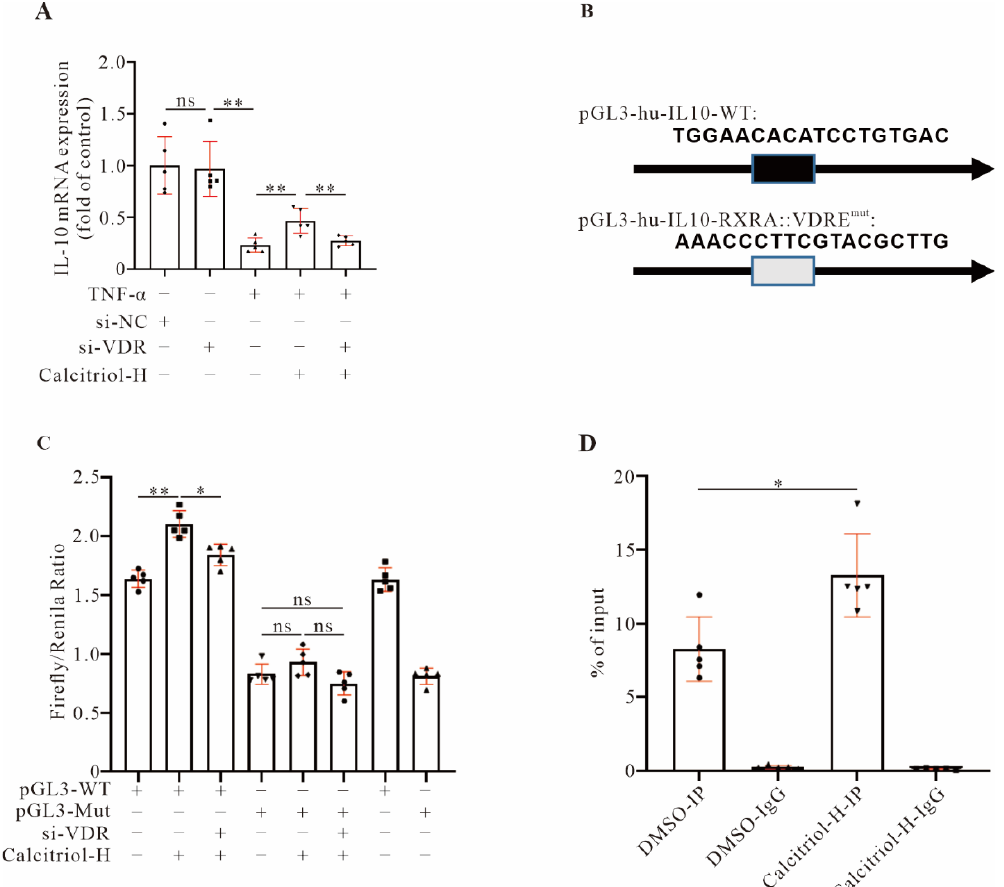
Figure 7. Calcitriol upregulated IL-10 expression by promoting direct binding of VDR with IL-10 gene promoter. ( A ) qRT-PCR analysis showed IL-10 expression in AC16 cells with the indicated treatments. ( B ) Schematic illustration of human IL-10 gene promoter vector harbouring a wild-type (pGL3-hu-IL-10-WT) or mutated version (pGL3-hu-IL-10-RXRA::VDRE mut ) of RXRA/VDR response element. ( C ) Luciferase reporter assay was performed in AC16 cells with indicated treatments ( n = 5). ( D ) CHIP assay showed calcitriol-H treatment promoted VDR binding to the human IL-10 gene promoter ( n = 5). (Data represent means ± S.D. * p < 0.05, ** p < 0.01, ns p > 0.05. Two- and three-way ANOVA with a post hoc test of Tukey’s analysis was used in ( D ) and ( A )/( C ), respectively).